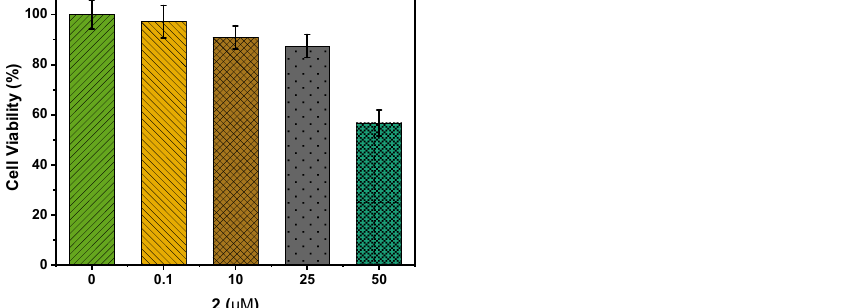
Figure 5. Cytotoxicity of compound 2 at 0, 0.1, 10, 25, and 50 µM was studied using A549 cells after 24 h in an MTT assay.